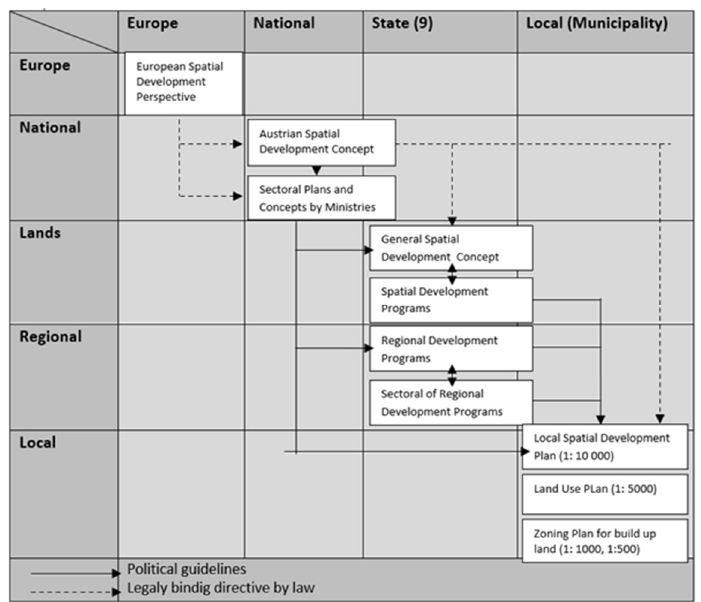
Figure 3. The Austrian spatial planning system: levels and instruments. Resources: Own compila- tion based on Schrenk, Neuschmind, and Wasserburger. [16].